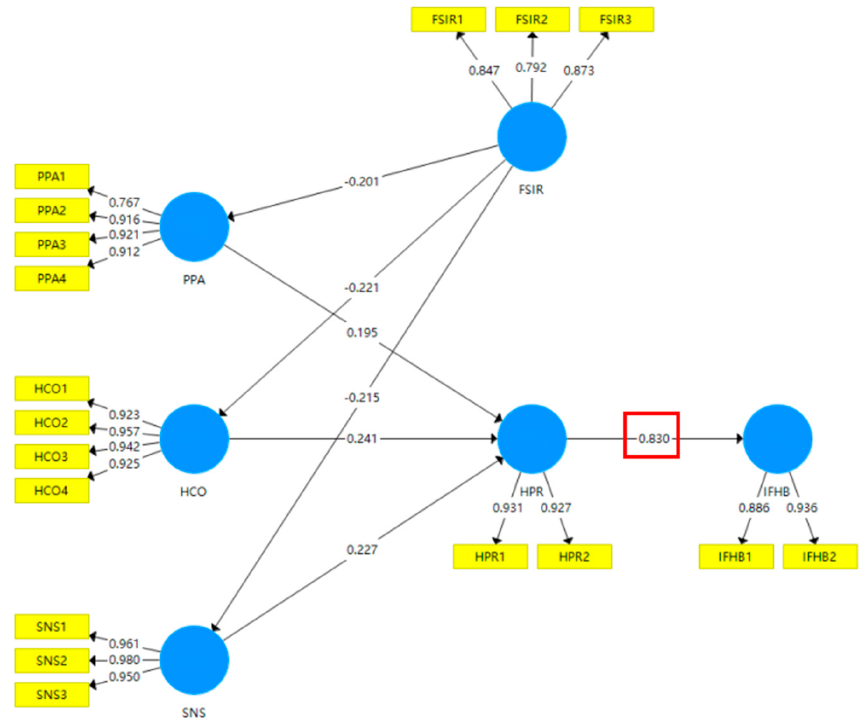
Figure 7. Model estimation results without consideration of the moderating effect of FSIR. Table 8. Detailed results of the structural equation.